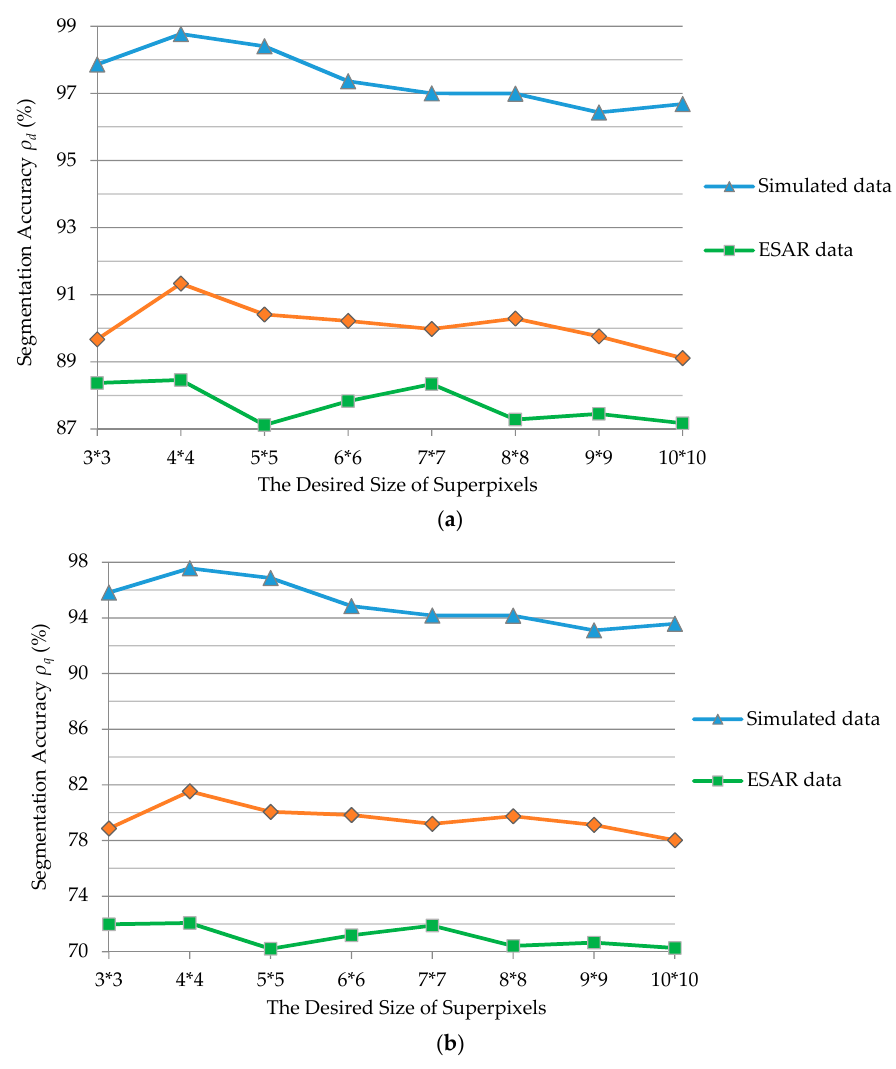
Figure 12. Segmentation accuracy obtained using the IFGS method for the simulated data, ESAR, and RADARSAT-2 data, with different desired sizes of superpixels: ( a ) detection rate; ( b ) quality rate.